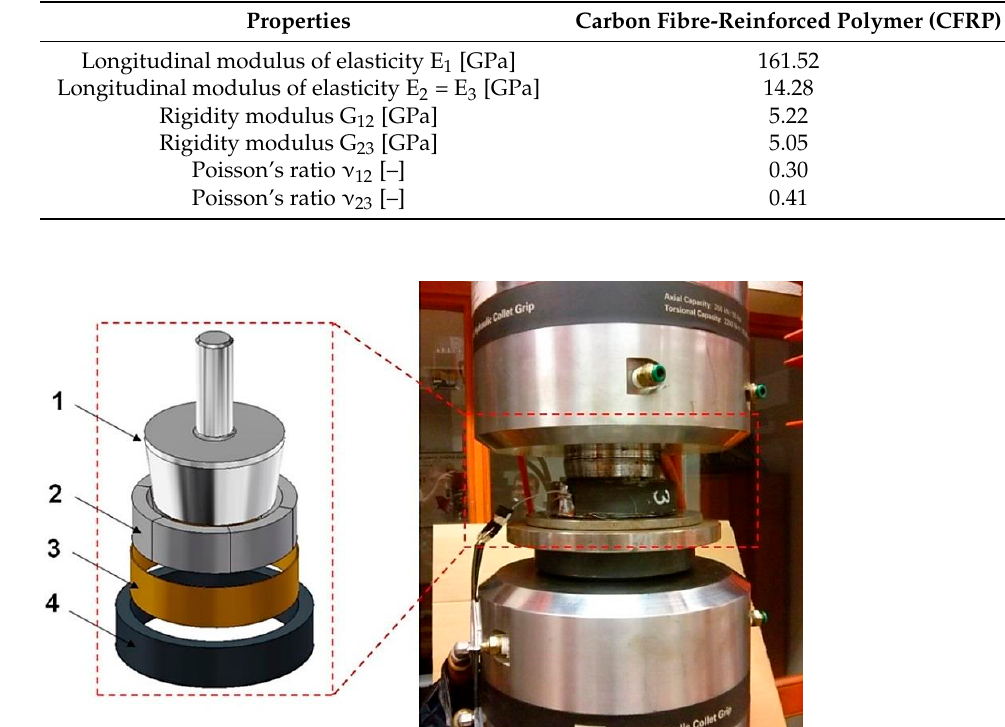
Table 3. Effective elastic properties of the manufactured composites.